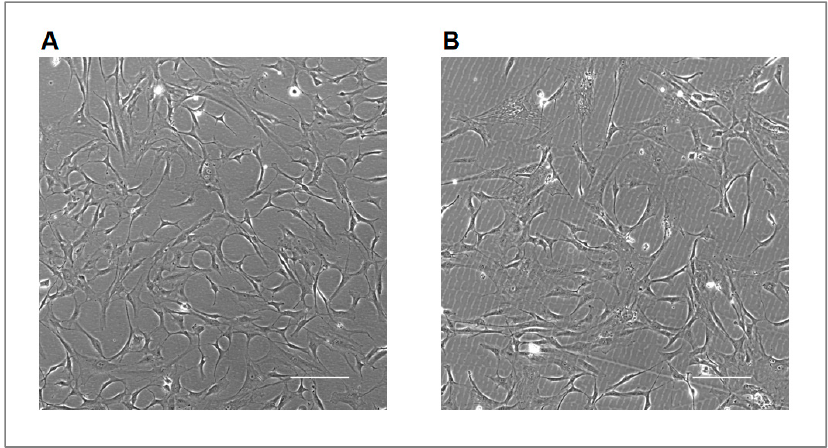
Figure 1. Cord blood (CB)- and adipose tissue mesenchymal stromal cells (AT-MSCs) maintain their spindle-shaped morphology under extracellular vesicles (EV) biogenesis conditions. MSCs were expanded to a confluence of about 80%, washed with Dulbecco’s phosphate-buffered saline and cultivated for 48 h in exosome-depleted medium. Then, the cells were switched to starvation medium for 24 h to derive the conditioned medium for EV isolation. Representative bright-field images of cell morphology of CB-MSCs ( A ) and AT-MSCs ( B ) were taken by phase-contrast microscopy at the time of EV isolation. Bars, 200 μ m.